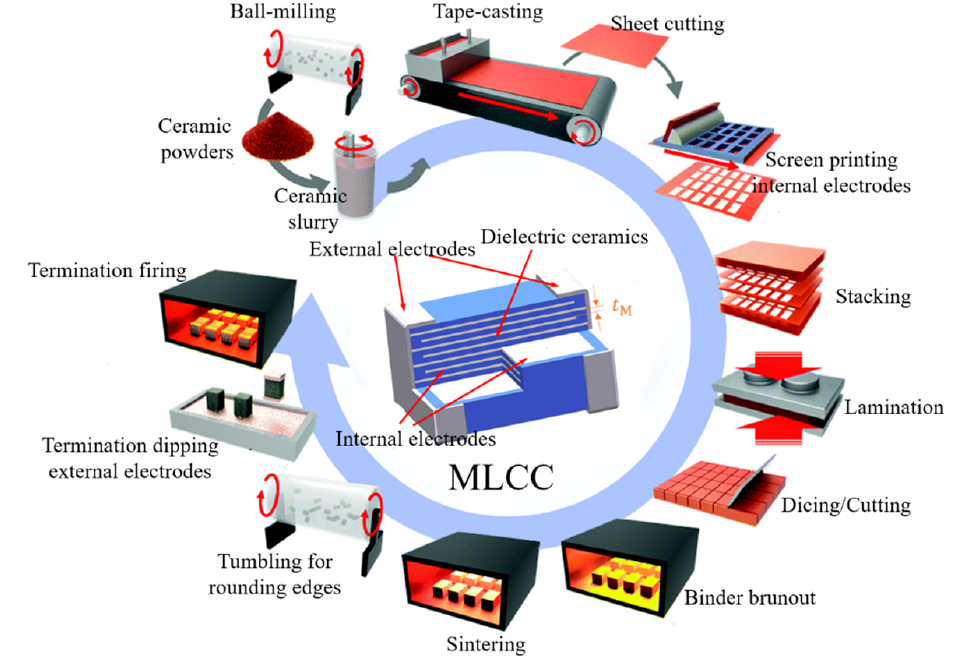
Fig. 23 Schematic diagram of MLCCs and their fabrication process. Reproduced with permission from Ref. [117], © The Royal Society of Chemistry